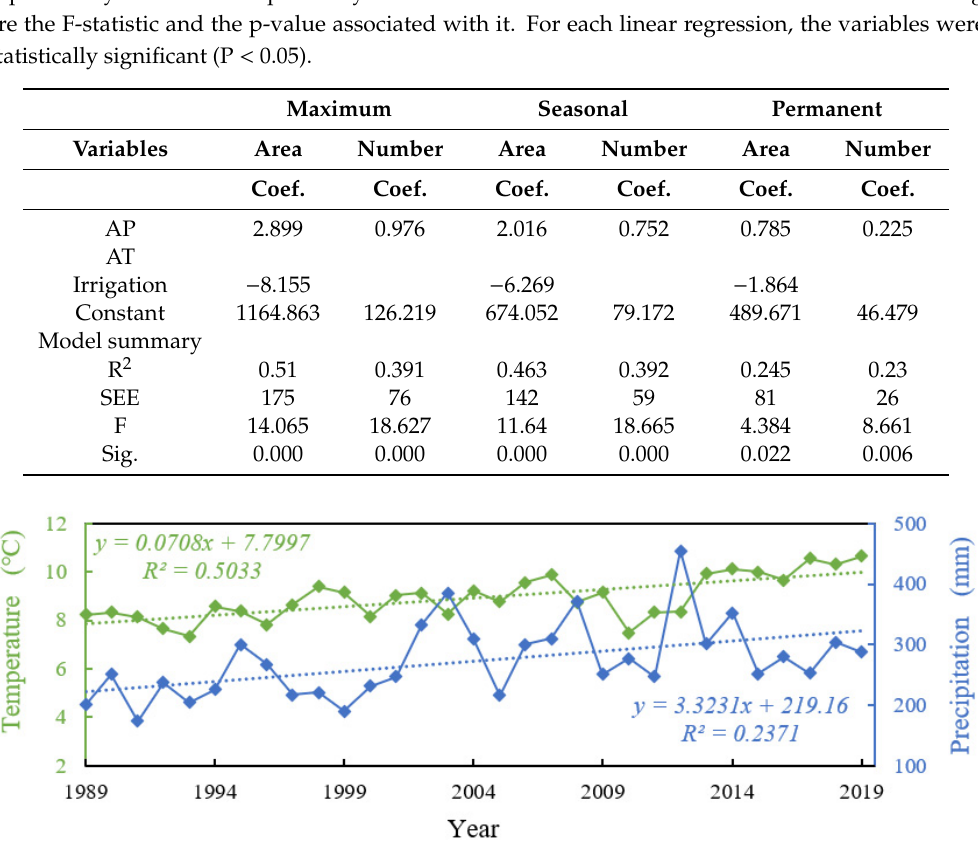
Figure 10. The trend of annual cumulative precipitation and the annual average temperature in the Hetao Plain from 1989 to 2019.